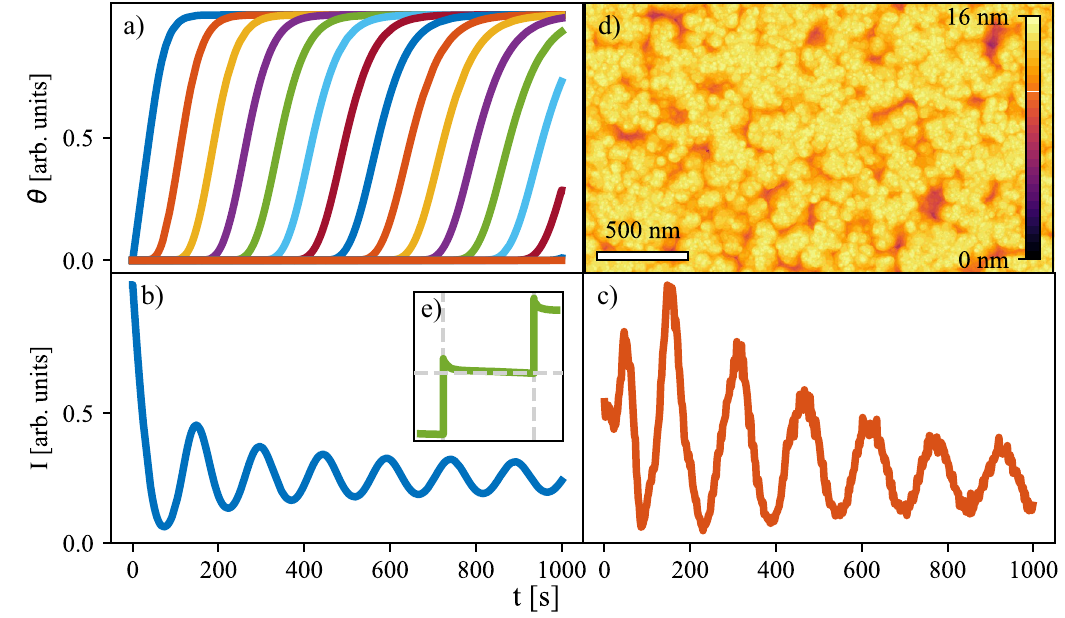
Figure 3. ( a ) The time dependencies of level coverages for first 1000 s, ( b ) the simulated anti-Bragg intensity, ( c ) the experimentally measured anti-Bragg intensity, and ( d ) the resulting morphology at the end of the simulation (8000 s). The inset ( e ) shows behaviour of level coverage after a pulse, the vertical dashed lines mark the depositions and the horizontal dashed line marks the level coverage at the last point before the pulse.